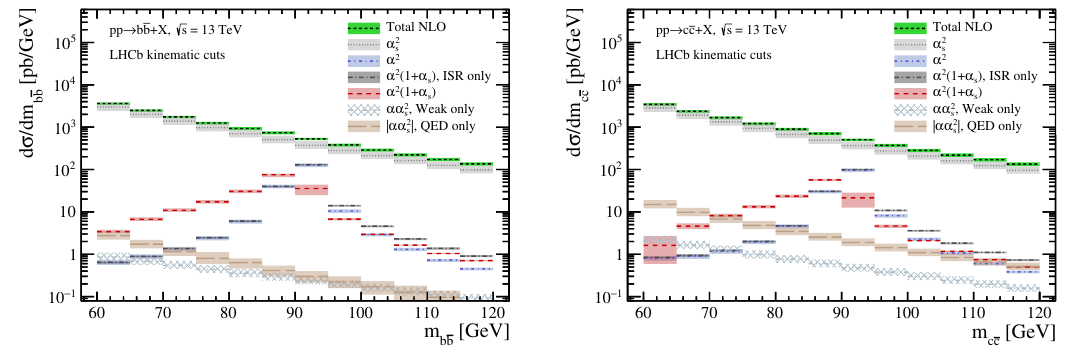
Figure 3 . Same as (cid:12)gure 2 but restricted to invariant masses m full NLO results various individual contributions are shown. See text for further